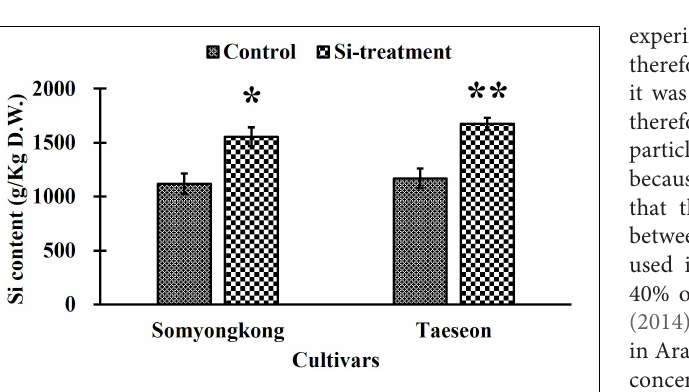
FIGURE 7 | Comparison of Si accumulation in contrasting soybean cultivars after Si treatment. Error bars indicate standard error, and the asterisks indicate significant differences using the T - test (*0.01 < P < 0.05; **0.001 < P <